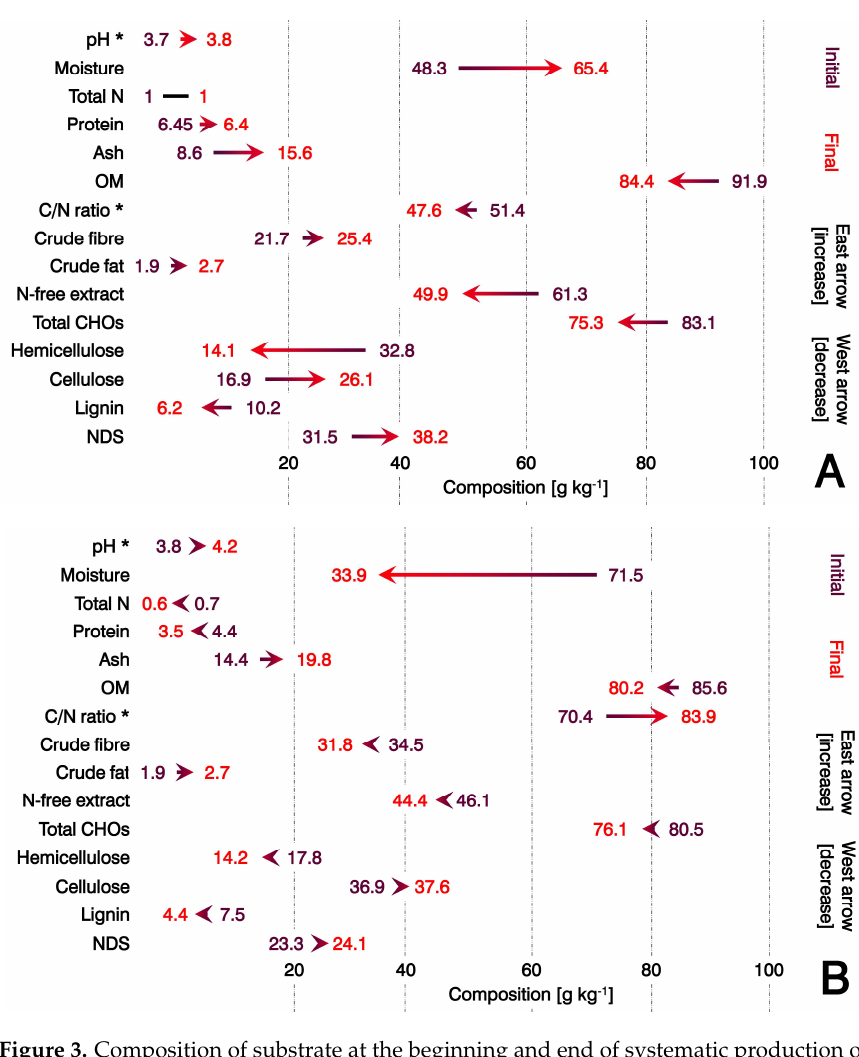
Figure 3. Composition of substrate at the beginning and end of systematic production of L. edodes in sawdust with hydration ( A ) and wheat straw without hydration ( B ). * Dimensionless variable.